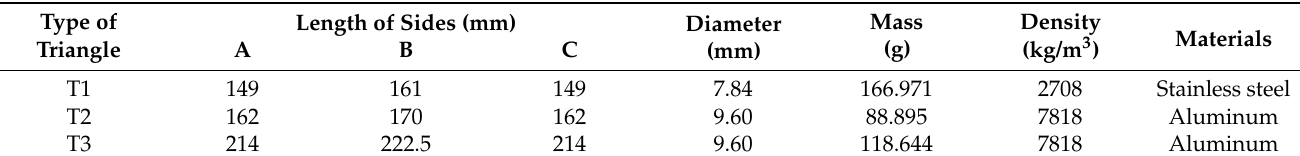
Table 1. The physical features of samples.